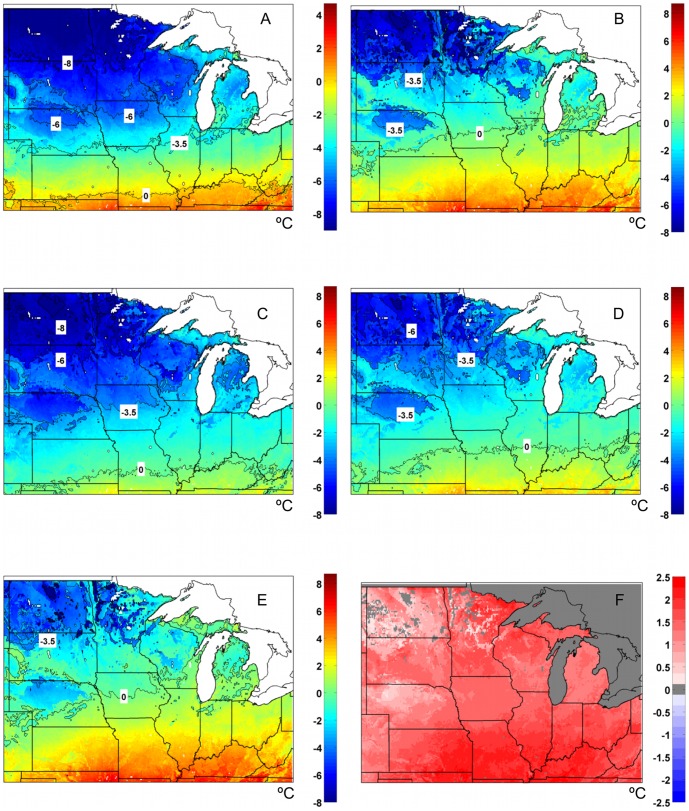
Impacts of soil surface residue management on annual average extreme minimum 10 cm soil temperatures.Average annual (1978–2007) extreme minimum 10 cm soil temperatures (based on 3-day running mean) for (a) MAIZE+TILL (bare soil post harvest), (b) MAIZE+NOTILL, (c) MISCAN+R1 cm, (d) MISCAN+R2.5 cm, and (e) MISCAN+R5 cm simulations. The position of the 0.0°C, −3.5°C, −6.0°C, and −8.0°C 10 cm soil temperature isopleths are highlighted by labels on solid black lines; (f) differences in average annual extreme minimum 10 cm soil temperatures for MISCAN+R5 cm – MAIZE+NOTILL (Fig. 6e–Fig. 6b results).